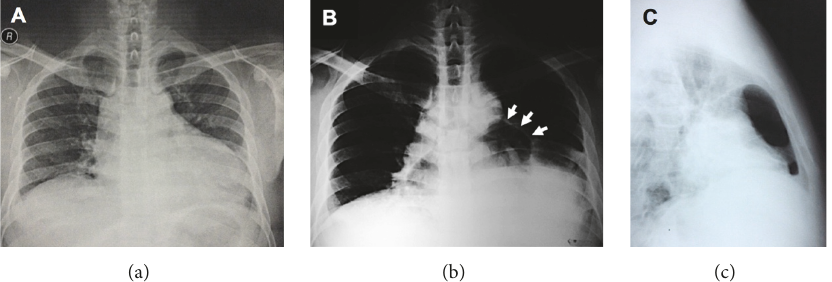
Figure 2: Evolution of the patient’s chest radiographs. The prepericardiocentesis film (a) showed cardiomegaly secondary to the massive pericardial effusion. Five days after removal of fluid, new pockets of radiolucency were detected within the cardiac silhouette on both frontal (b) and lateral (c) projections, representing air within the pericardium (arrows pointing at outline of the